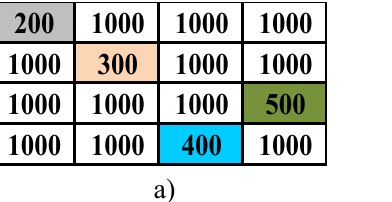
Figure 10. PSC before reconfiguration ( a ) case I, ( b ) case II. Figure 11. PSC after reconfiguration ( a ) case I, ( b ) case II. Figure 11. PSC after reconfiguration ( a ) case I, ( b ) case Figure 11. PSC after reconfiguration ( a ) case I, ( b ) case II.